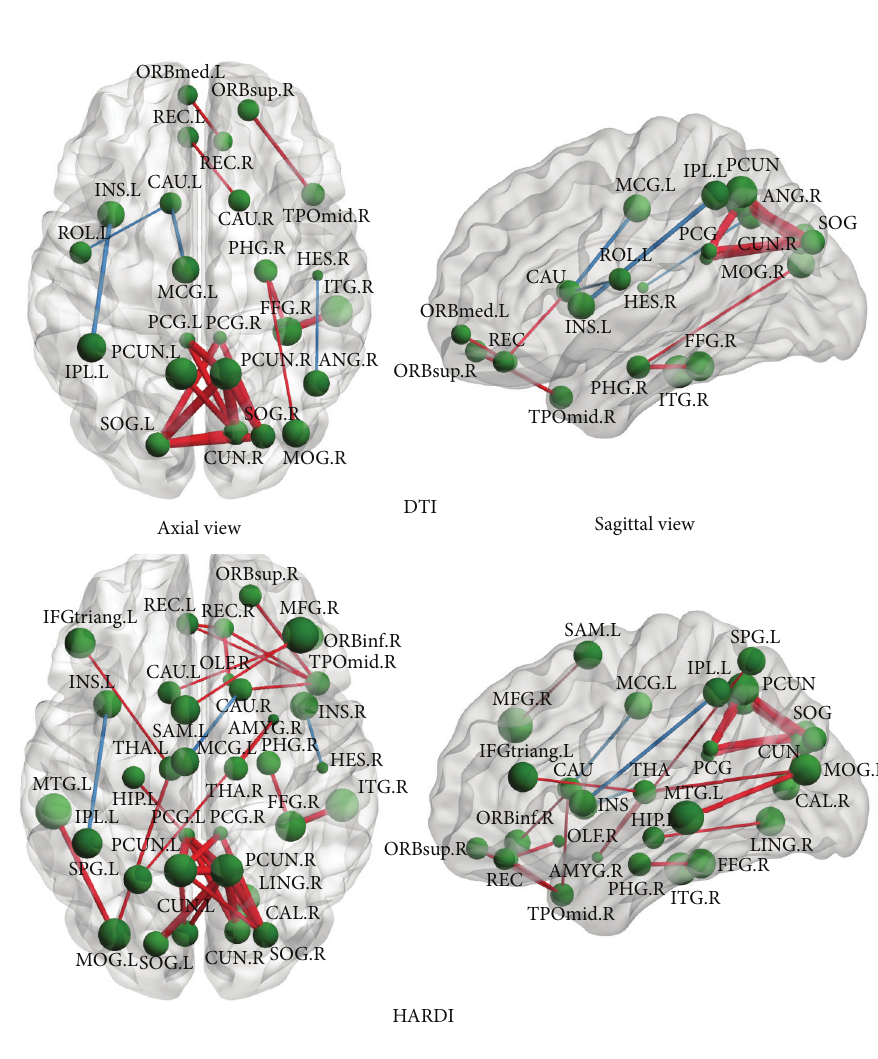
Figure 6: The axial and the sagittal views of the significantly different connections ( 𝑝 < 0.05 ) based on the fiber counts between the AD group and the NC group given by the DTI and HARDI methods, respectively. The stronger connections (higher fiber counts between a pair of ROIs) in the AD group are shown in blue , while the weaker connections (lower fiber counts between a pair of ROIs) are in red . Refer to Table 2 for the label of each